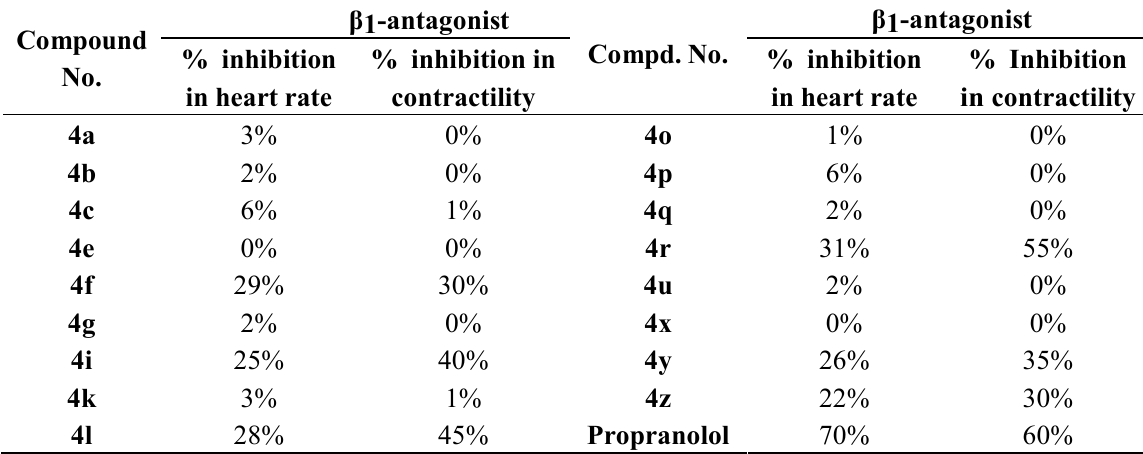
Table 4. The percent inhibition in the heart rate and the contractility of the isolated guinea pig atria caused by the tested